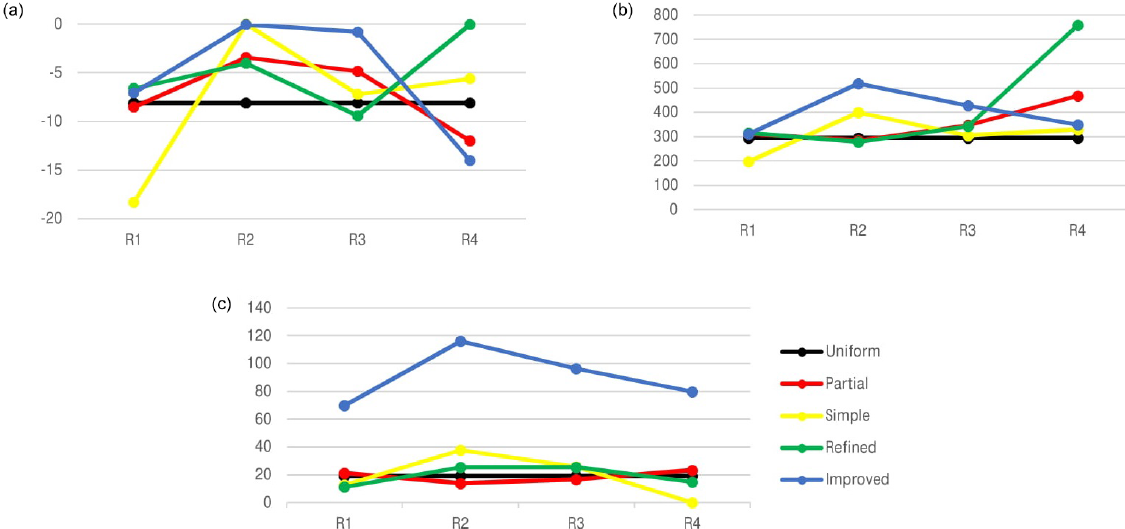
Figure 6. COV parameters of the different strategies in each region: (a) R E − R B (km), (b) A (mGal 2 ), and (c) α